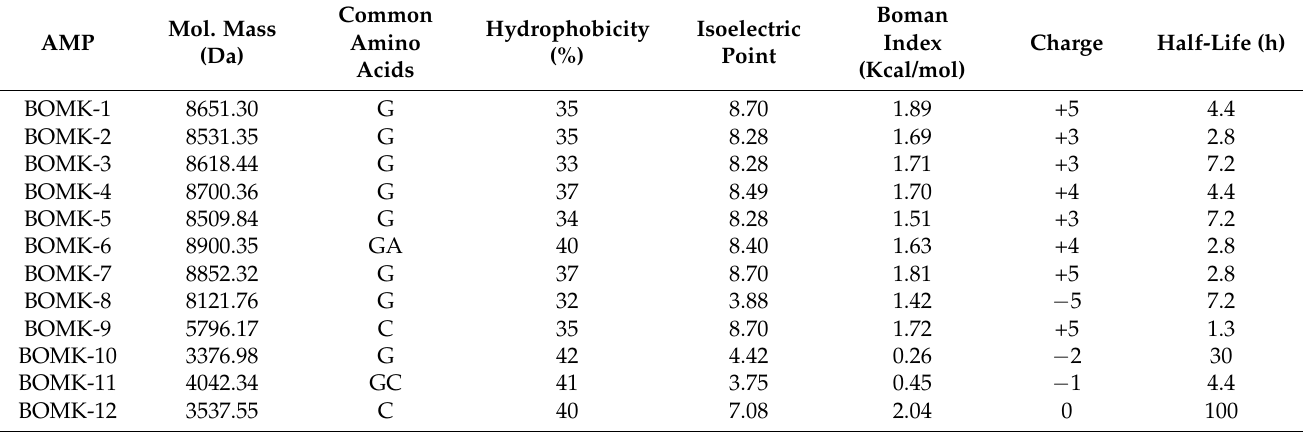
BOMK1–12: Anti- Fusarium oxysporum